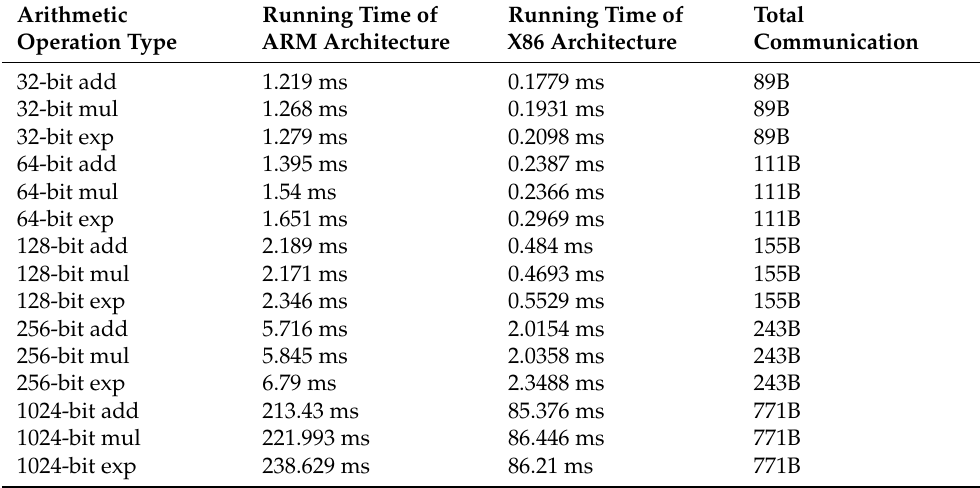
Table 3. Performance of LPCP on additive, multiplicative and exponential operations.